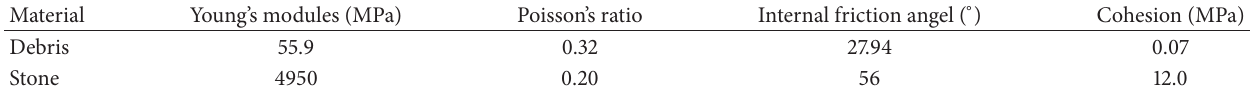
Table 2: The macromechanical parameters of outwash